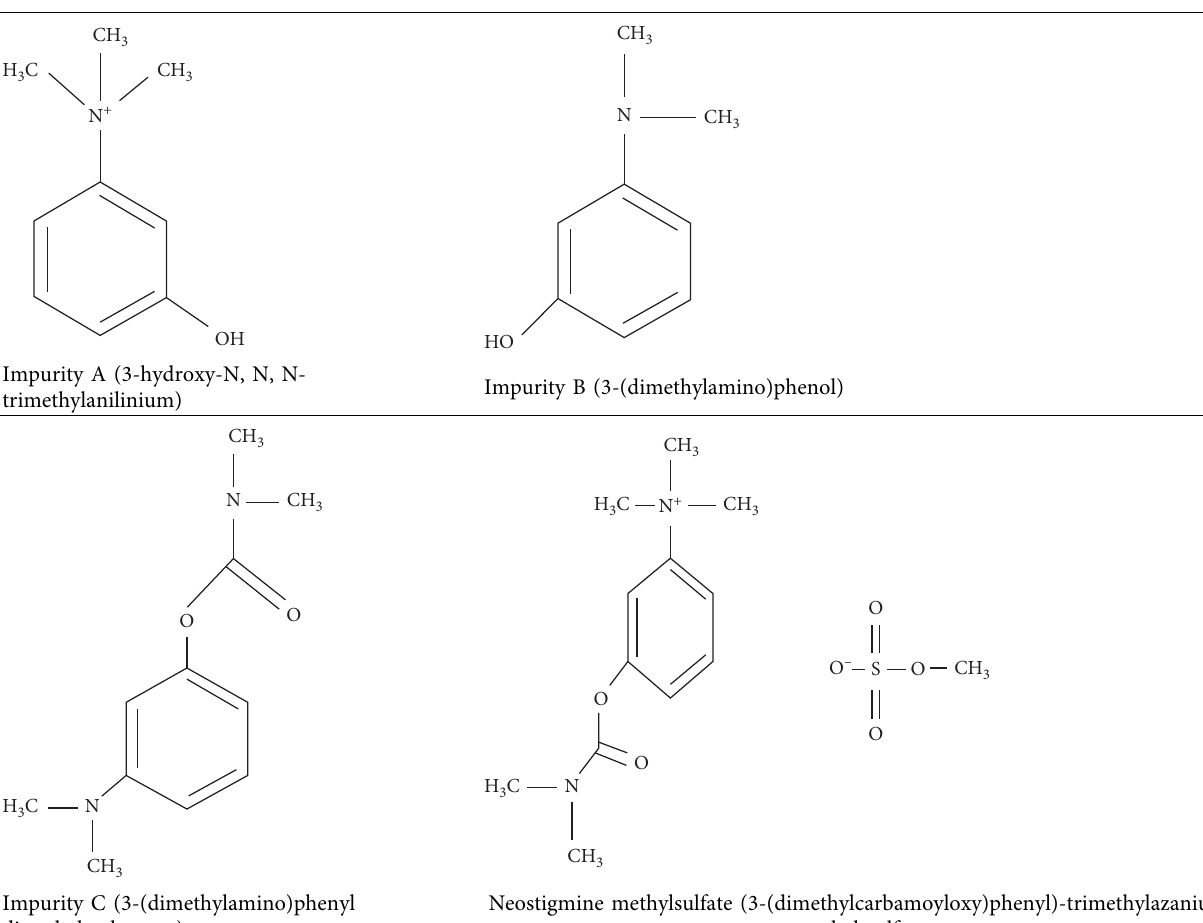
Table 1: Chemical structures of neostigmine methylsulfate and its EP reported impurities [19].